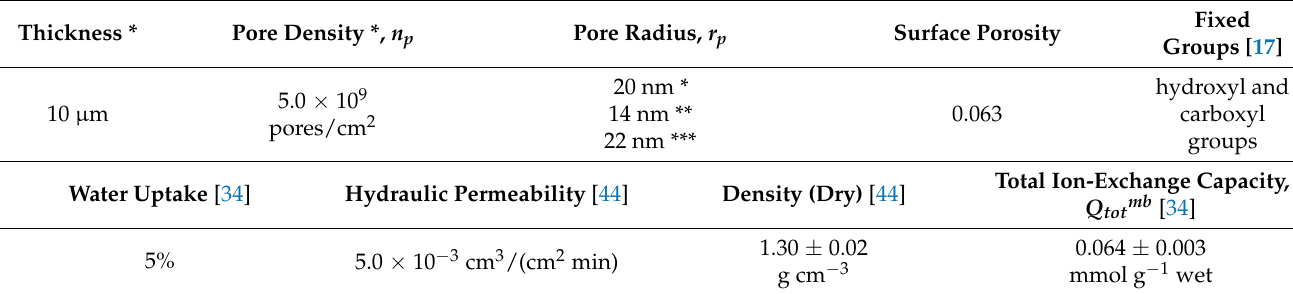
Table 1. Some characteristics of